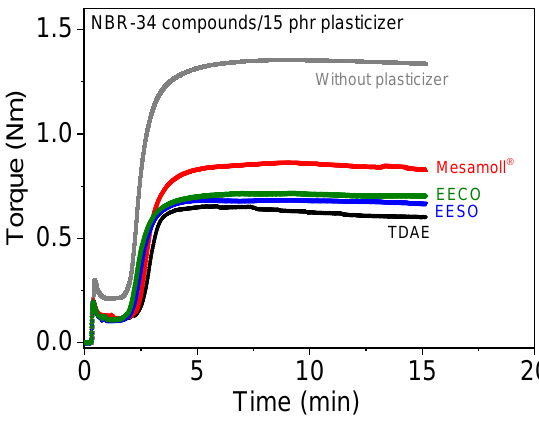
Figure 1. Vulcanization curves of various plasticized NBR compounds.